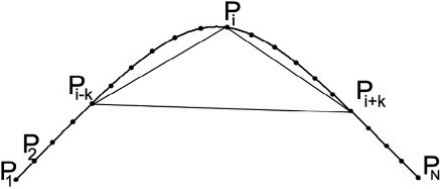
Figure 1. The curvature estimation measurement algorithm we